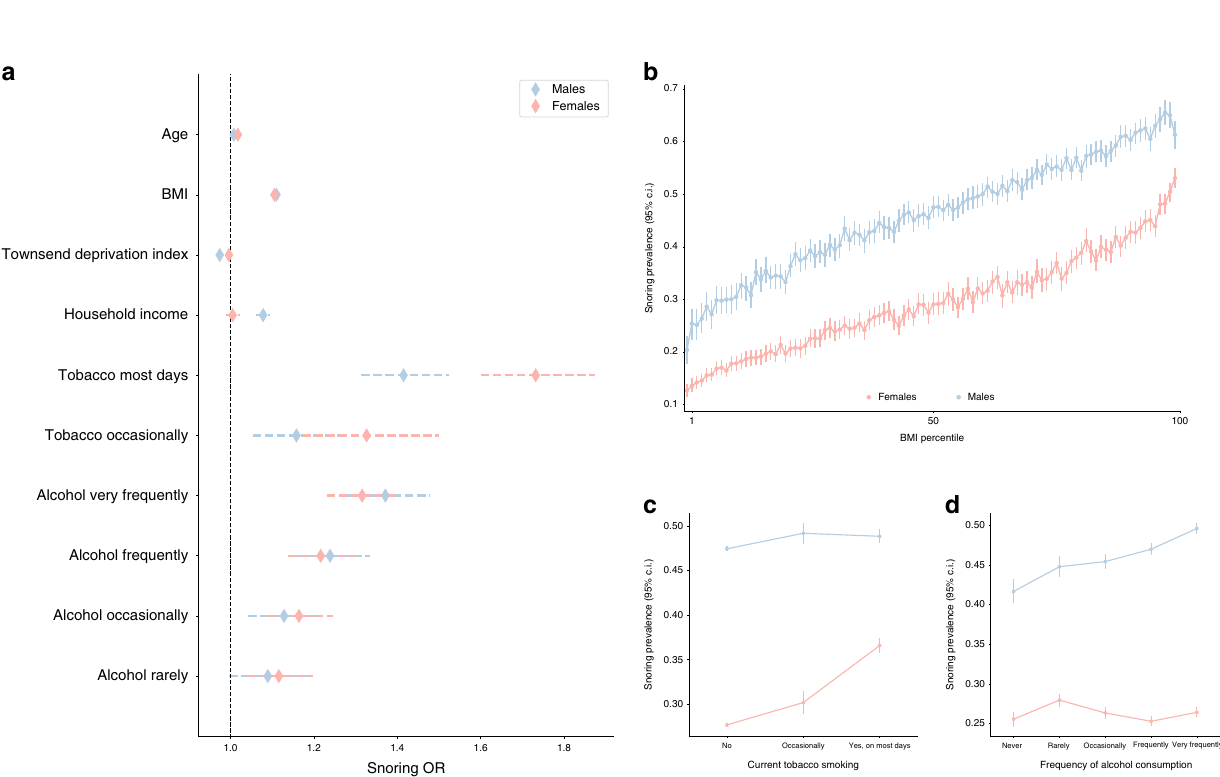
Fig. 1 Lifestyle and demographic factors associated with increased snoring. a Forest plot depicting the odds ratios of studied variables on snoring for males (blue) and females (red). b Sex- and BMI-strati fi ed prevalence of snoring. c Sex- and frequency of tobacco smoking-strati fi ed snoring prevalence. d Sex- and frequency of alcohol consumption-strati fi ed snoring prevalence. Error bars denote the 95% con fi dence intervals estimated using the odds ratio and SE ( a ) or 1000 pseudo replicates from a bootstrap resampling procedure ( b , c , d ).